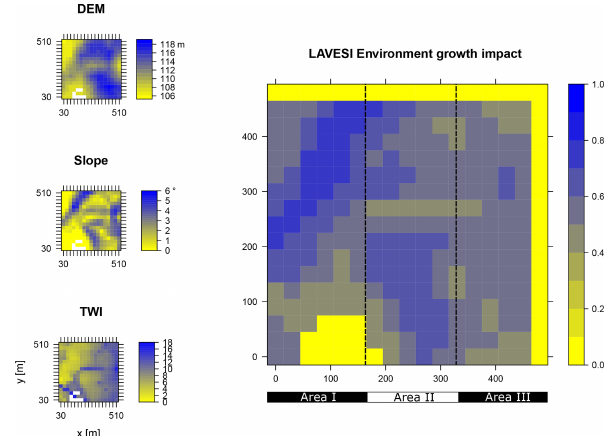
Figure B2. Elevation (DEM), slope angle, and terrain water index (TWI) define the environment growth impact (0 no growth possible; 1 good, no constraints) using an empirically fitted function for present forest growth at the area of interest